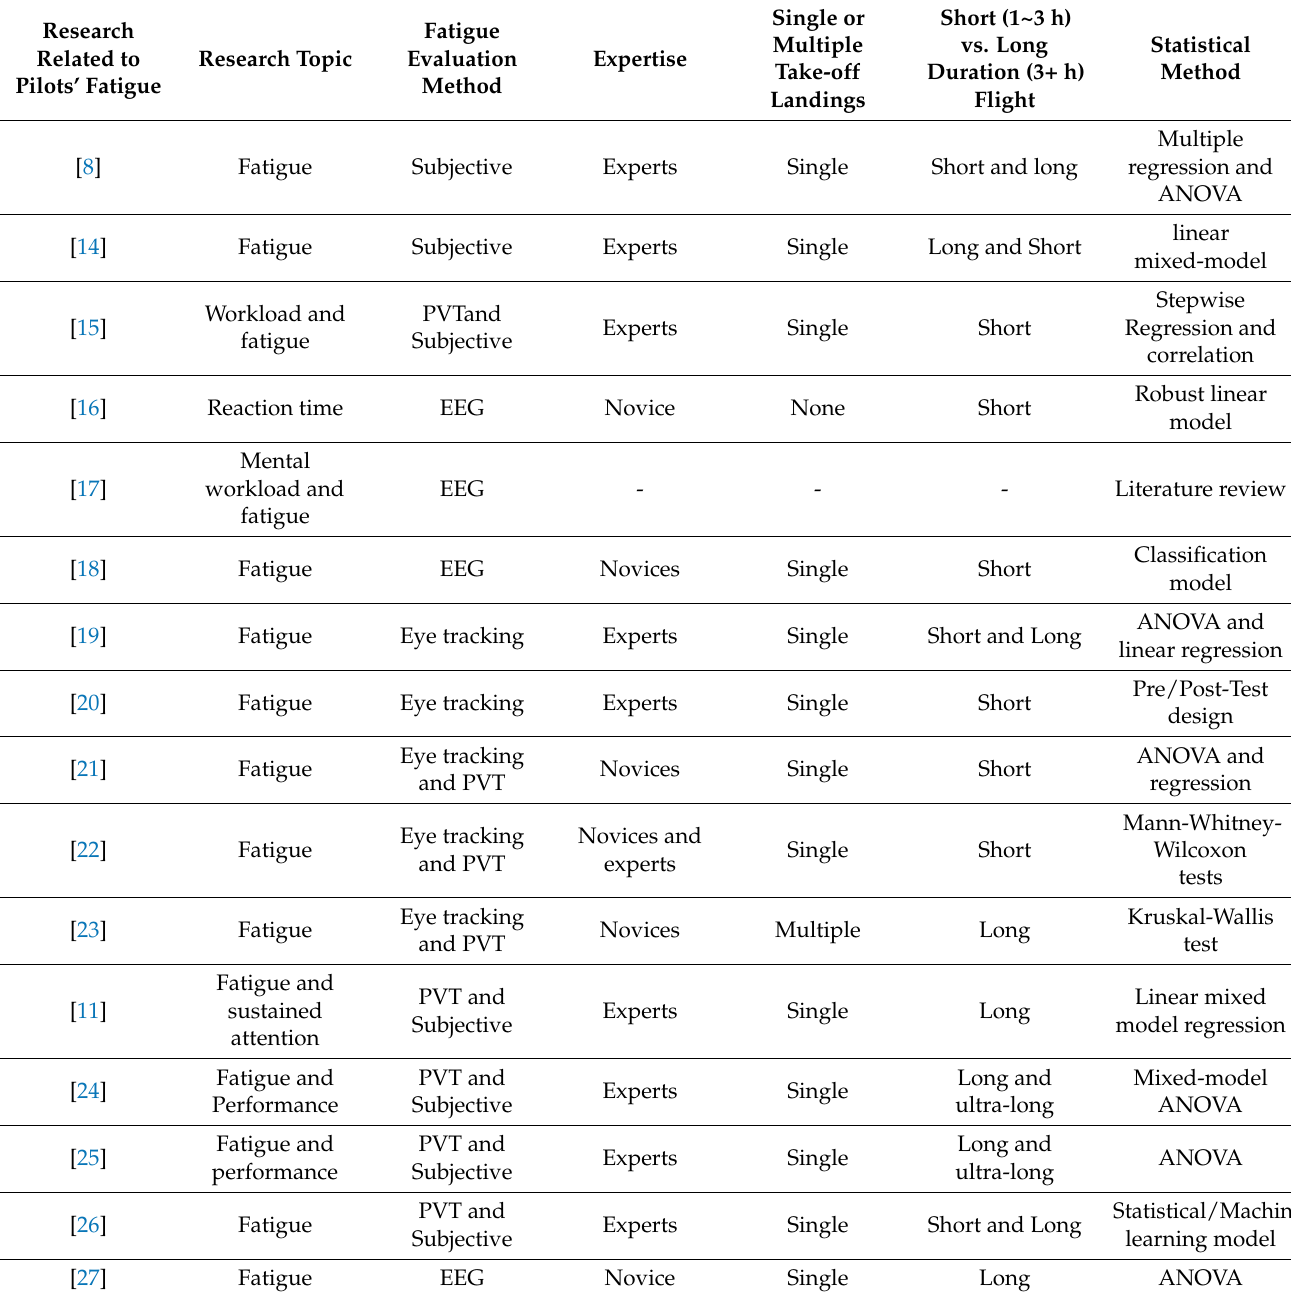
Table 1. Classification of existing research in pilot fatigue: Classifications are mostly based on the fatigue evaluation method. The last three listed in the table are studies not related to fatigue but worth mentioning. Research Related